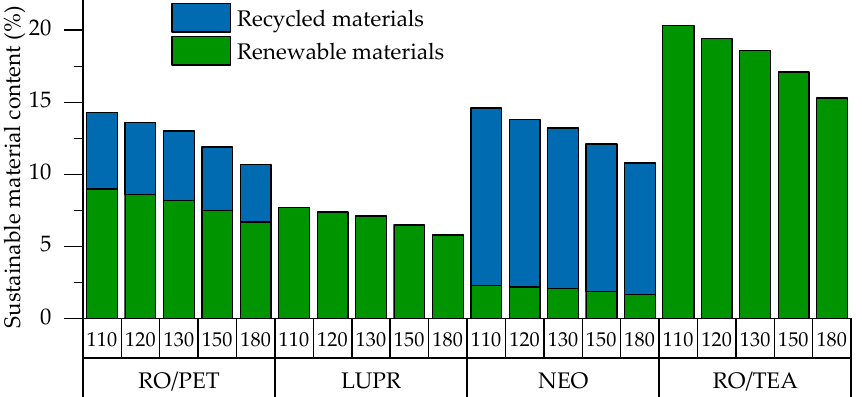
Figure 1. Sustainable material content in all series of rigid PUR foams